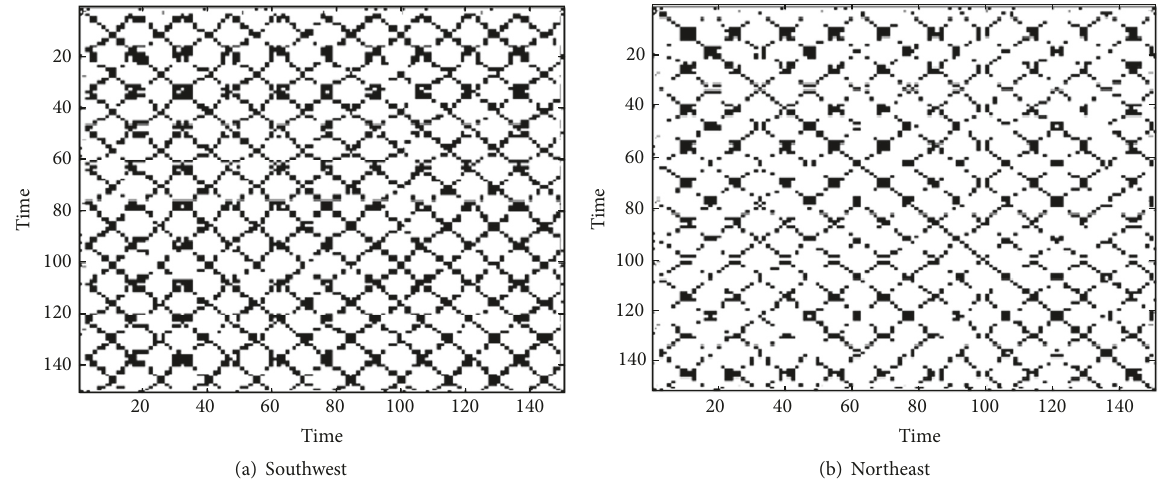
Figure 12: Recurrence plots for the regions in